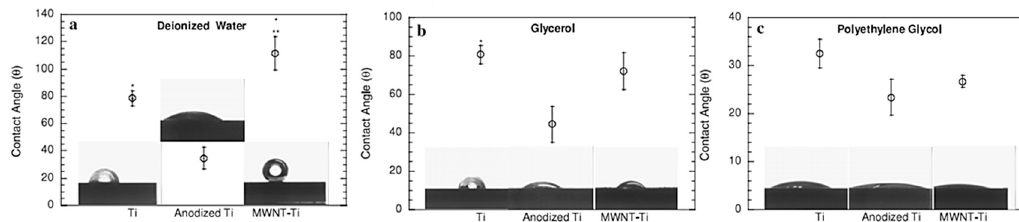
Figure 5. Contact angle measurements with three liquids using an EasyDrop model system (Kr¨uss): ( a ) double-deionized water, ( b ) glycerol, and ( c ) polyethylene glycol (PEG), all on conventional pure Ti, anodized Ti, and MWNT–Ti. Data = mean ± SEM; n = 3; * p < 0.01 compared to anodized Ti and ** p < 0.01 compared to Ti. (Reprinted with permissions from [38], IOP Publishing Group 2011 copyright n. 1003986).